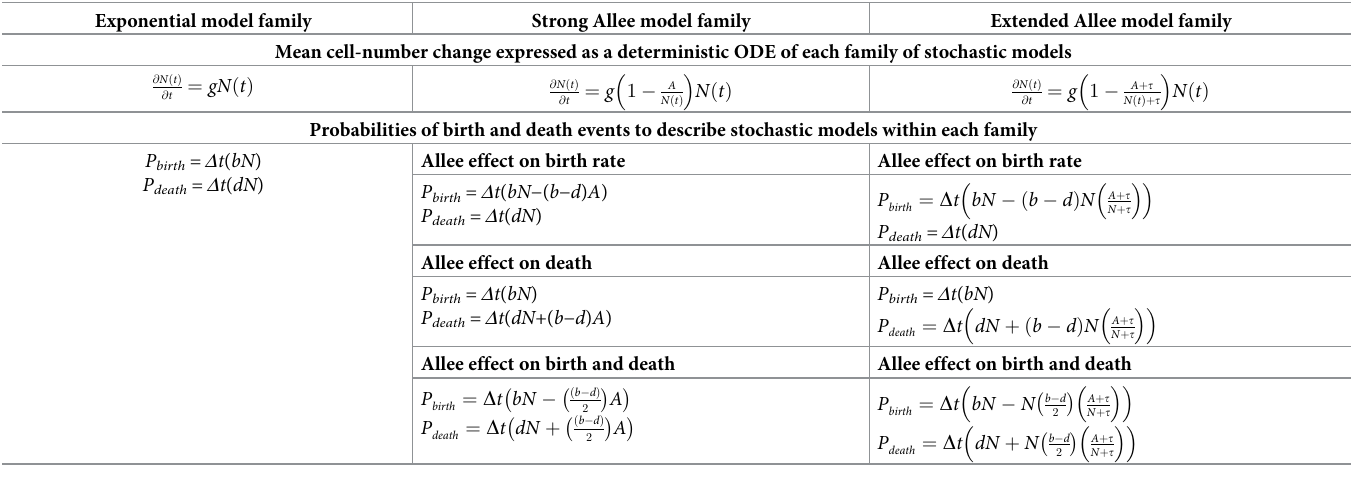
Table 1. Stochastic growth model families whose average behavior correspond to one of the deterministic growth models. For the Allee model families, within each family, the Allee effect can alter birth, death, or both probabilities, representing distinct mechanistic hypotheses. Exponential model family Strong Allee model family Mean cell-number change expressed as a deterministic ODE of each family of stochastic models